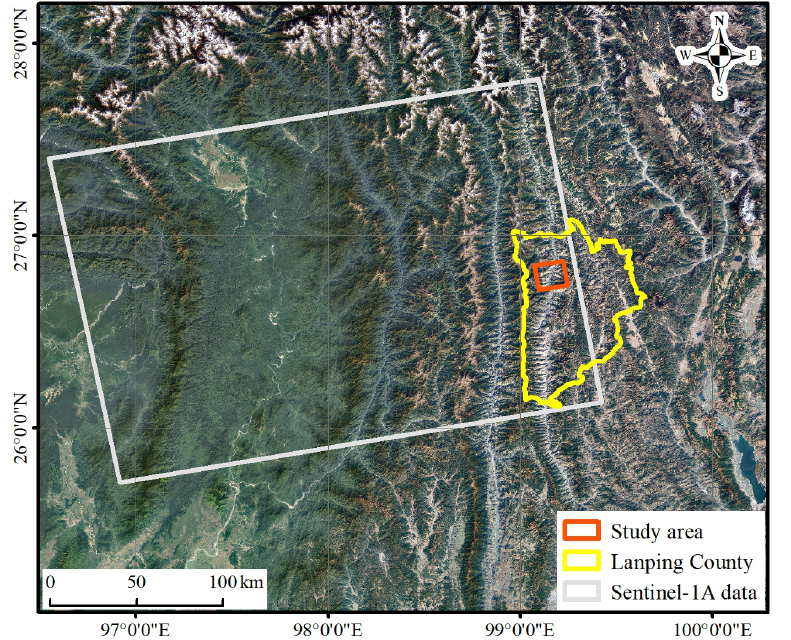
Figure 2. The Sentinel-1A SAR data